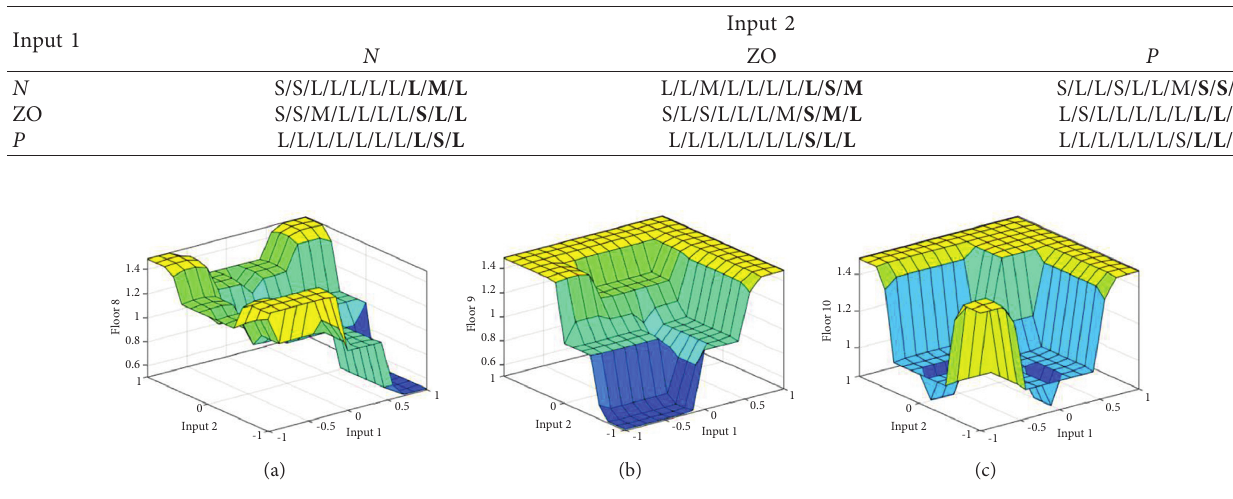
Figure 6: Curve surfaces of fuzzy rules for the top three floors: (a) rule surface for floor 8, (b) rule surface for floor 9, and (c) rule surface for floor 10.